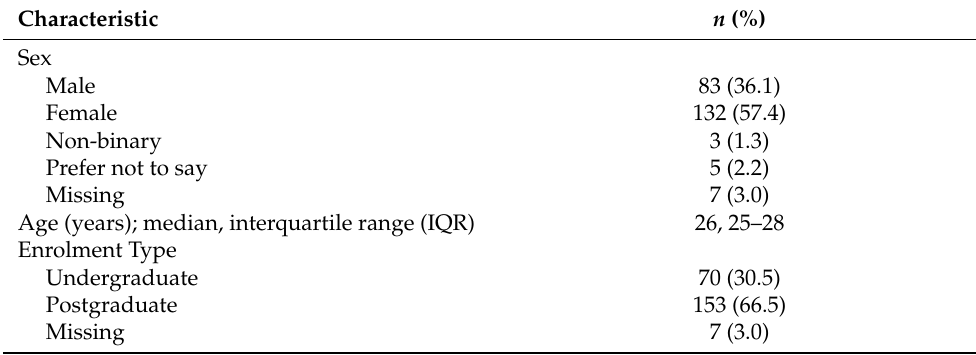
Table 1. Participant characteristics of the total sample ( n =